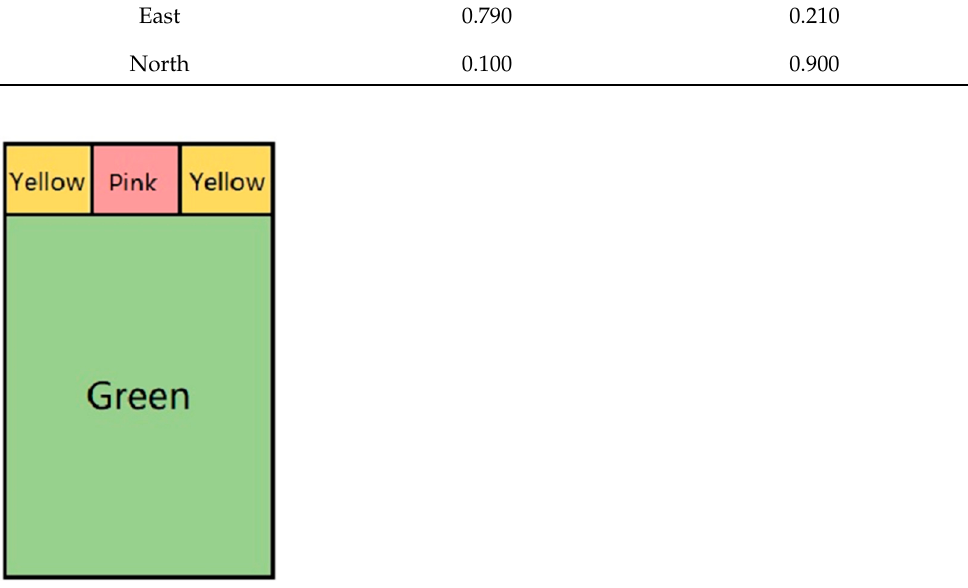
Table 9. The weights of UDI 450 − 2000lux [ 50% ] and UDI 2000lux [50%] in the north- and east-facing rooms. Table 9. The weights of 𝑈𝐷𝐼 (cid:2872)(cid:2873)(cid:2868)(cid:2879)(cid:2870)(cid:2868)(cid:2868)(cid:2868)(cid:2922)(cid:2931)(cid:2934) [50%] and 𝑈𝐷𝐼 (cid:2870)(cid:2868)(cid:2868)(cid:2868)(cid:2922)(cid:2931)(cid:2934) [50%] in the north- and east-facing Table 9. The weights of 𝑈𝐷𝐼 (cid:2872)(cid:2873)(cid:2868)(cid:2879)(cid:2870)(cid:2868)(cid:2868)(cid:2868)(cid:2922)(cid:2931)(cid:2934) [50%] and 𝑈𝐷𝐼 (cid:2870)(cid:2868)(cid:2868)(cid:2868)(cid:2922)(cid:2931)(cid:2934) [50%] in the north- and east-facing rooms. rooms.